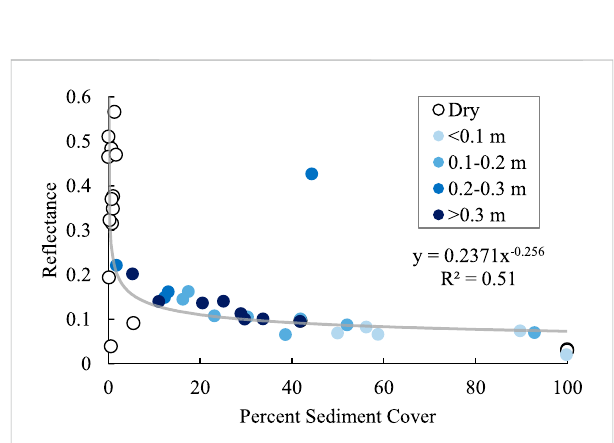
FIGURE 2 Scatterplot of re fl ectance values for each of ASD measurement and the sediment cover derived from classi fi ed handheld imagery of the ground surface within the ASD fi eld of view. Colors indicate the water depth of the measurement site. The least-squares trendlinewasusedtodeterminethealbedoof0.07for100%sediment cover where y is re fl ectance, and x isthe percent sediment cover. R 2 is the coef fi cient of determination of the